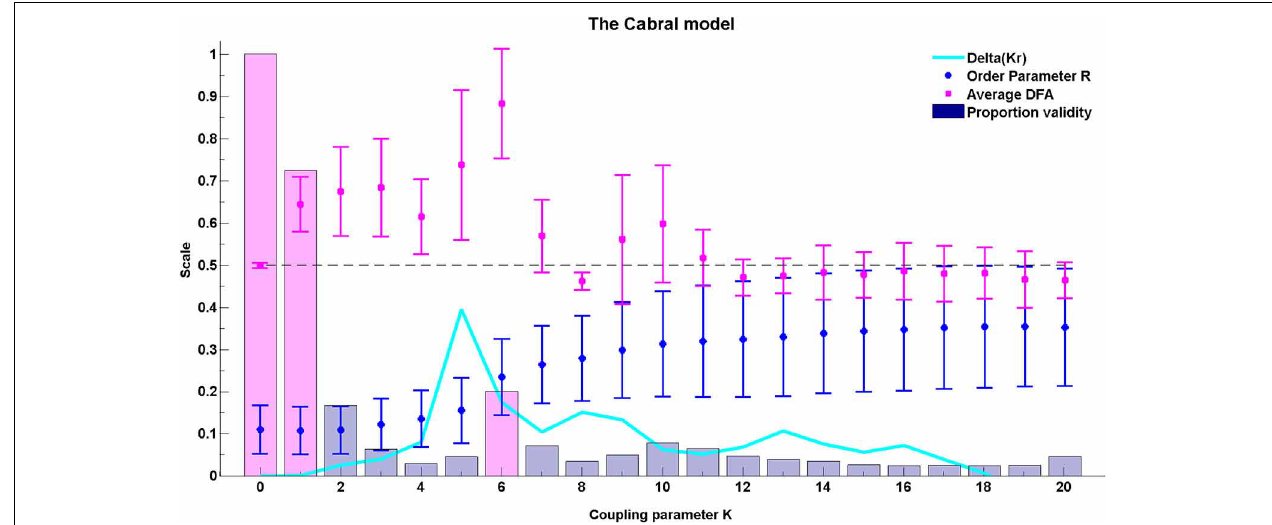
FIGURE 10 | The average DFA exponents of phase synchrony as a function of the coupling parameter, K , in the extended Kuramoto model (Cabral et al., 2011). The model includes 66 oscillators at normally distributed natural frequencies with mean 60 Hz and standard deviation = 1 . 25. The connectivity and time delay matrices are set from empirical σ i values. The average of the valid DFA exponents is shown in magenta and the